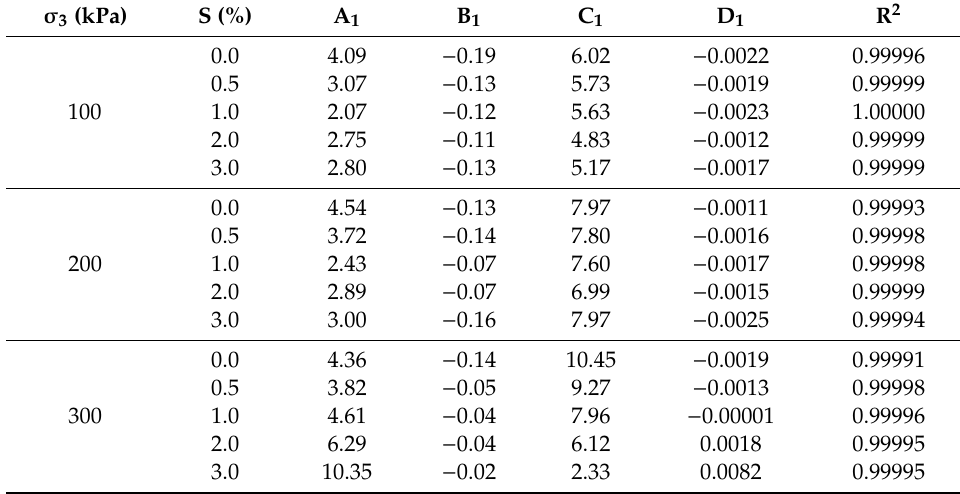
Figure 5. Variation of E i with FTC: ( a ) σ 3 = 100 kPa; ( b ) σ 3 = 200 kPa; ( c ) σ 3 = 300 kPa. Table 7. Parameters of exponential functions that can reflect relationship between E i and FTC under different σ 3 and S.